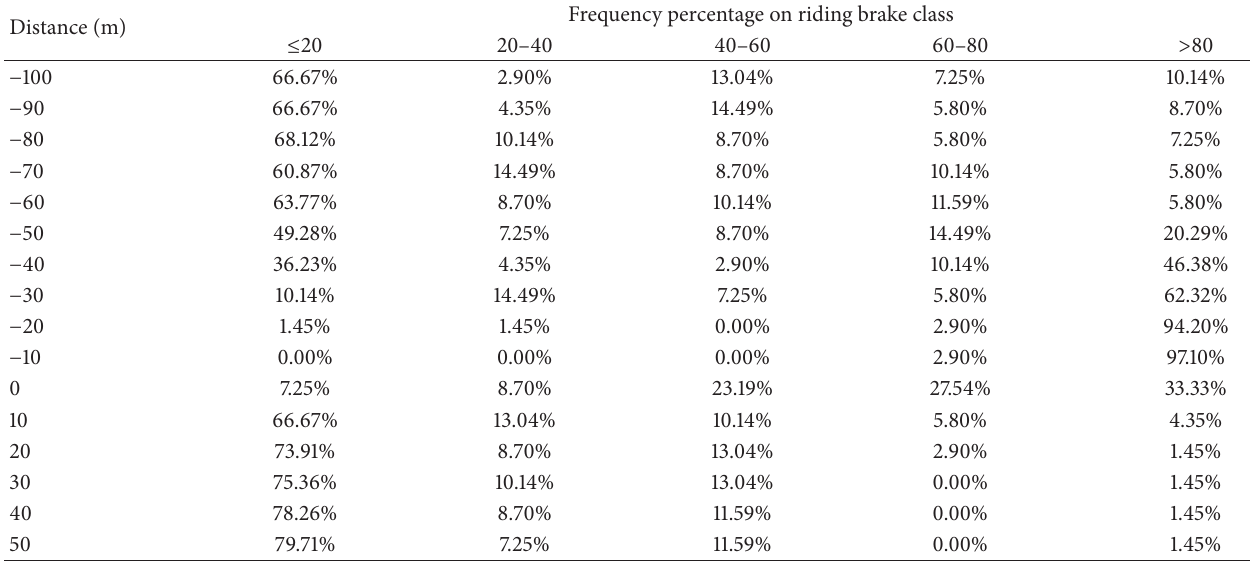
Table 3: Frequency percentage on brake applied in various distances from speed table.